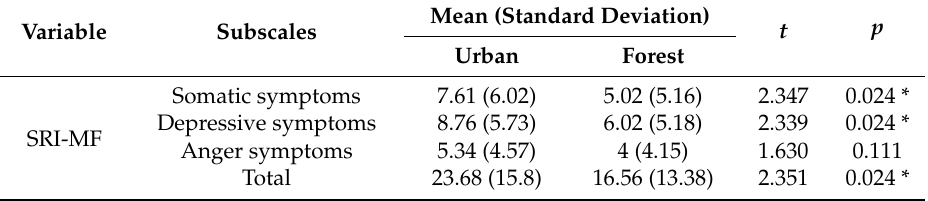
Table 4. Effect of exposure to forest environment on serum pro-inflammatory cytokine and GPx levels.